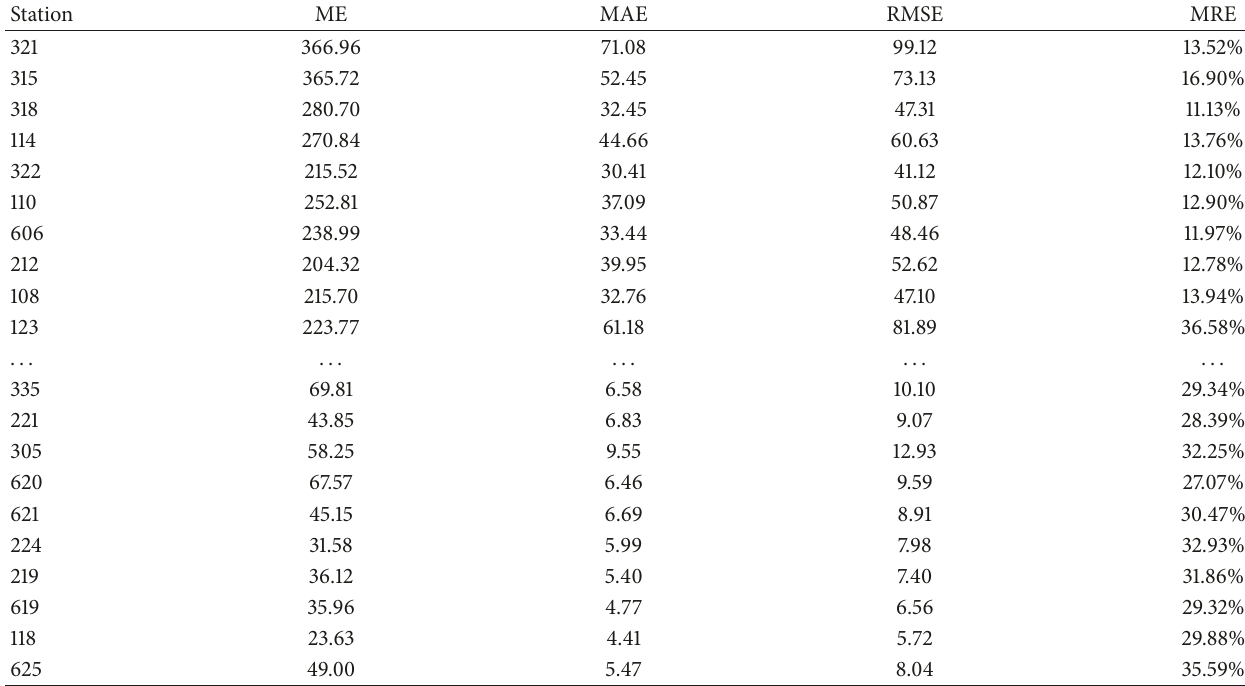
Table 2: Forecast performance of ST-LSTM network on different stations.